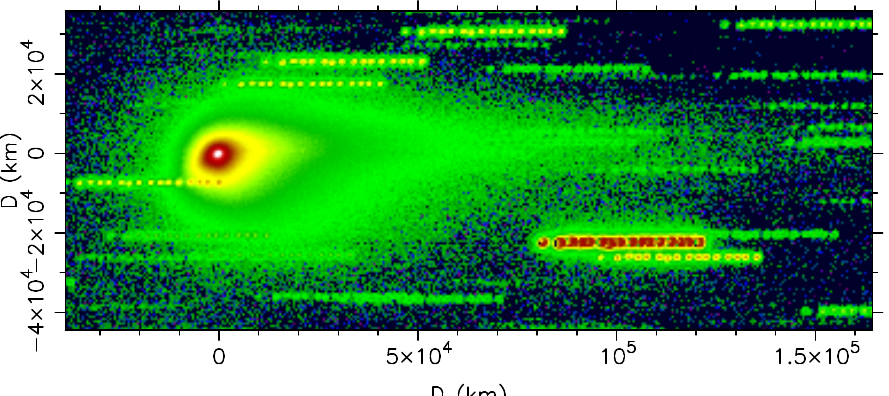
Figure 2. Image of comet 67P acquired at the Calar Alto Observatory 3.5 m telescope, using the Multi Object Spectrograph for Calar Alto (MOSCA), on 17 August 2015, at a heliocentric distance of 1.24 au. North is up, east is to the left. Distances ( D ) are projected distances at the nucleus position in the sky. Adapted from